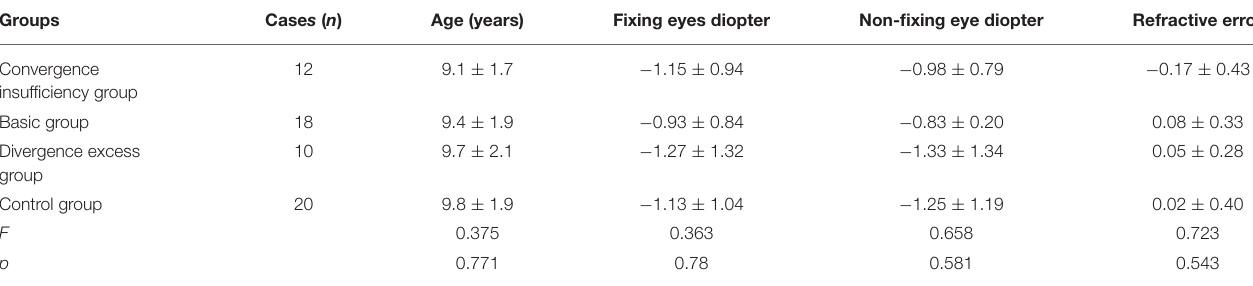
TABLE 1 | Comparison of general information among four groups (x ± s ).